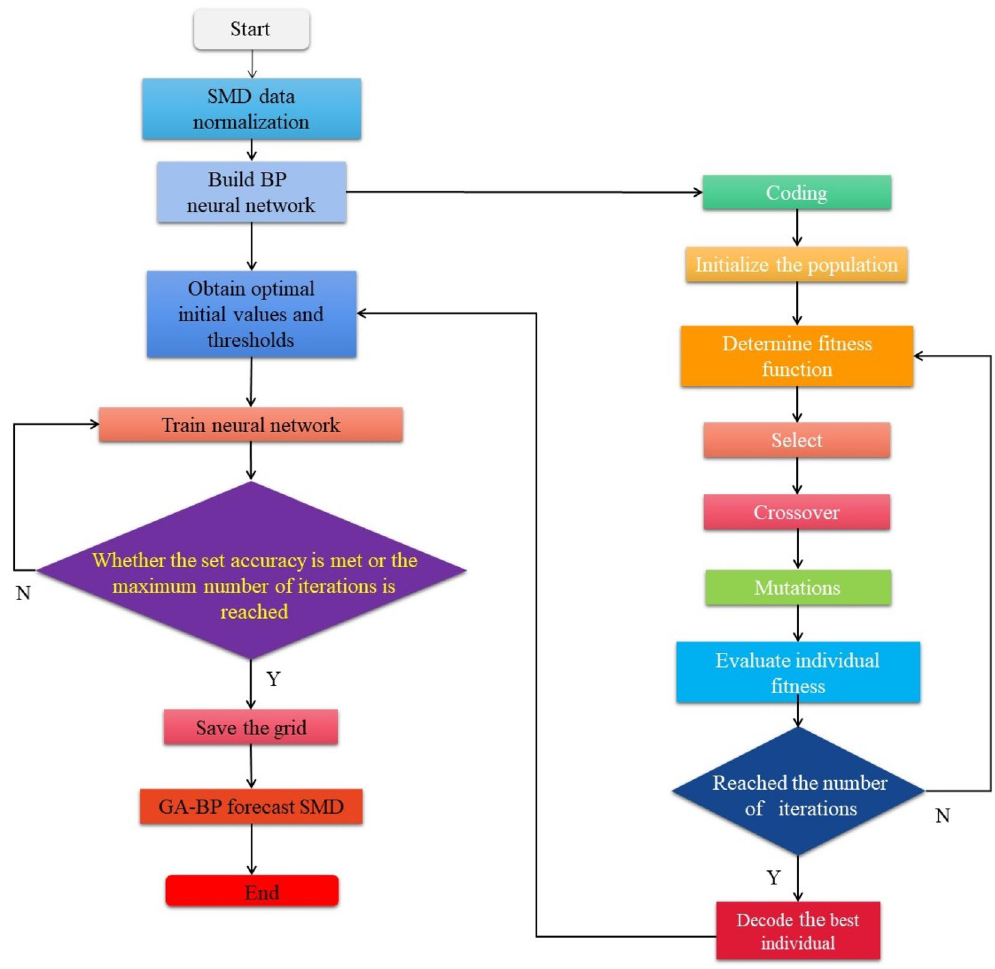
Figure 8. The processing flow of GA-BP neural